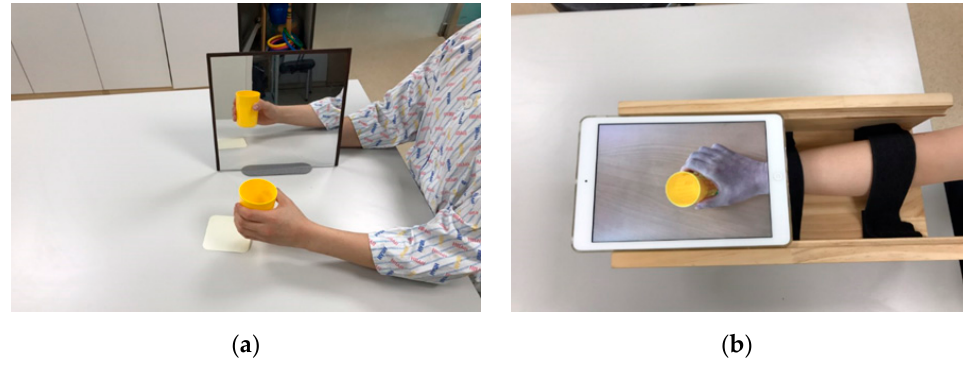
Figure 1. Protocols for two different MT methods: ( a ) BMT and ( b ) UMT.